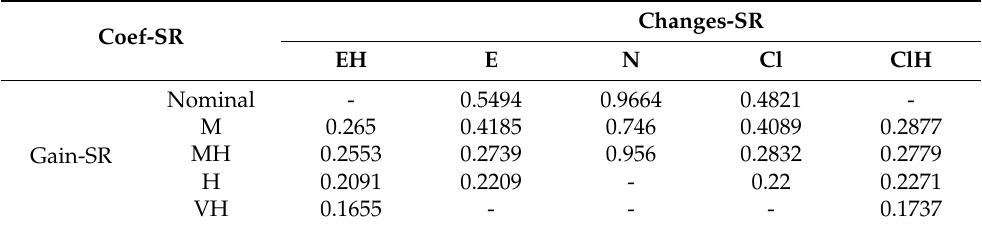
Table 4. Rules base of the ANFIS